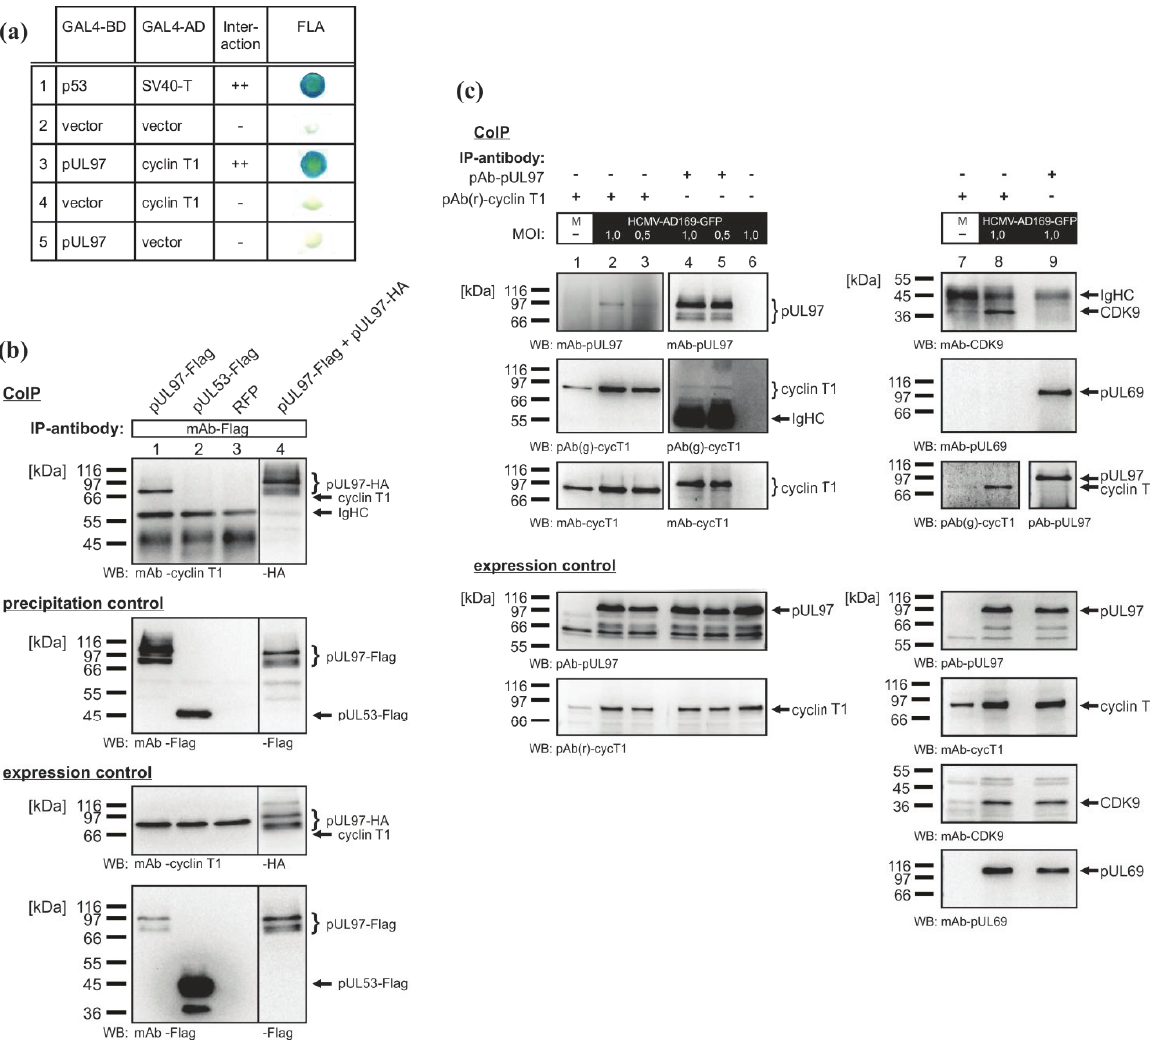
Figure 2. Direct interaction between pUL97 and cyclin T1. ( a ) Yeast two-hybrid (Y2H) analysis: cyclin T1 fused to the GAL4 activation domain (AD) and pUL97 fused to the GAL4 binding domain (BD) were coexpressed in yeast cells, and colonies were stained in filter lift assays (FLA). ( b ) co-immunoprecipitation (CoIP) analyses using protein lysates of transfected 293T cells: the self-interaction of pUL97 served as a positive control (lane 4) and pUL53-Flag as a negative control (lane 2). ( c ) CoIP analyses showing the interaction between pUL97 and cyclin T1 in HCMV-infected cells: human foreskin fibroblasts (HFFs) were infected with HCMV AD169-GFP at a multiplicity of infection (MOI) of 0.5 or 1.0. At six days post-infection, infected and mock-infected (M) cells were lysed and used for CoIP analyses. IP, immunoprecipitation; WB, Western blot